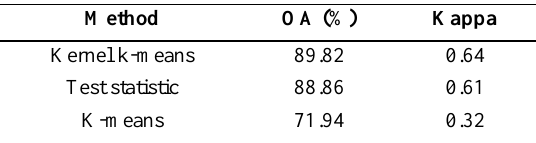
Fig. 6. Change detection results in Region 1, (a) proposed method, (b) test statistic based on Wishart distribution, (c) k- means clustering, (d) ground truth Table 1 Performance evaluation of the change detection